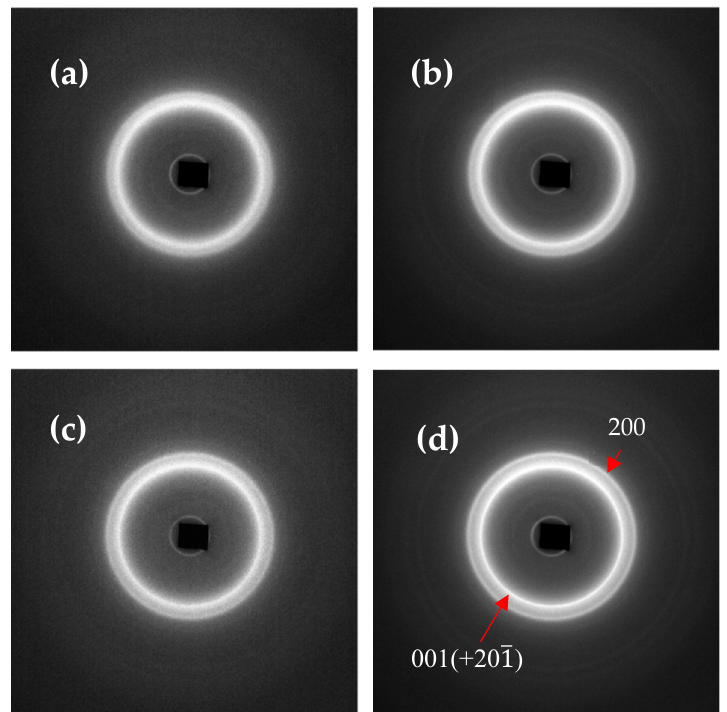
Figure 5. Two-dimensional WAXS patterns for the in situ non-isothermal crystallization experiments. ( a ) Sample I, ( b ) Sample II, ( c ) Sample III and ( d ) Sample IV. Inner and outer peaks were found to be due to background diffraction from the sample holder.